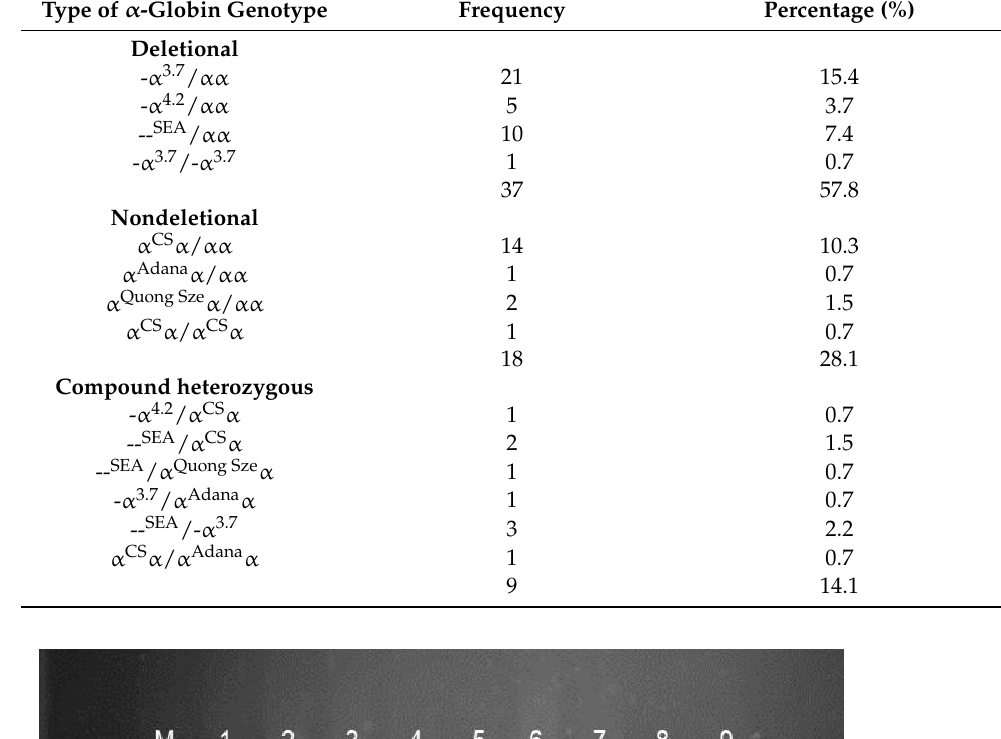
Table 1. Types of α -globin genotypes identified.